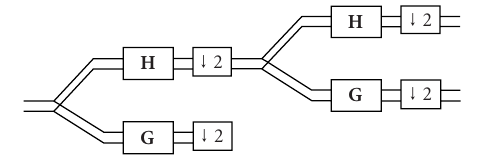
Figure 1: Implementation of multiwavelet decomposition with fil-